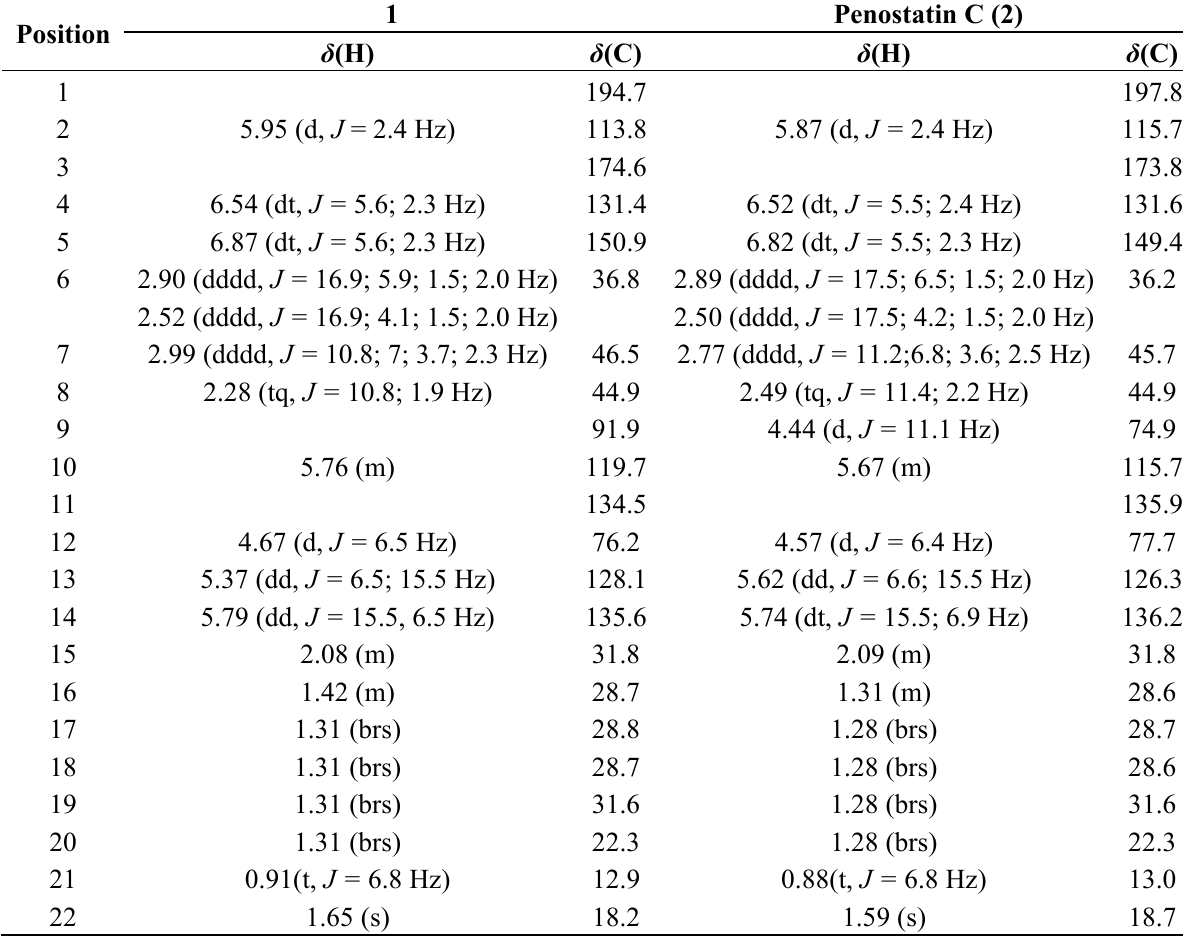
Table 1. 1 H and 13 C-NMR data for 1 and penostatin C ( 2 ).